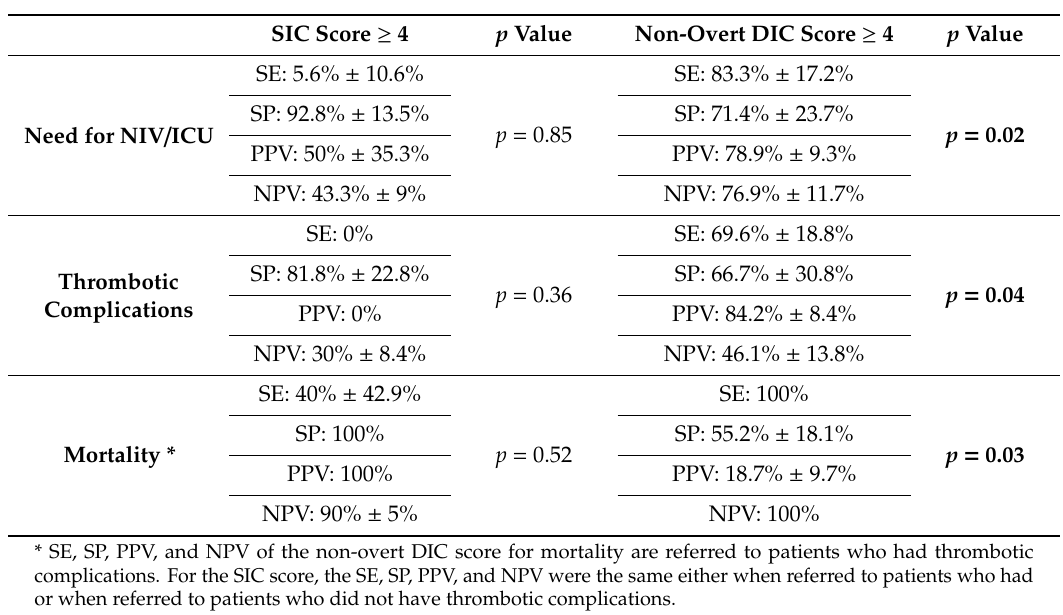
Table 4. Sensitivity (SE), specificity (SP), positive predictive value (PPV), and negative predicting value (NPV) of the SIC and of the non-overt DIC scores at cut-o ff values ≥ 4 for the need of non-invasive ventilation (NIV) / intensive care unit (ICU) admission and occurrence of thrombosis and mortality, with each respective p value. 95% confidence intervals are